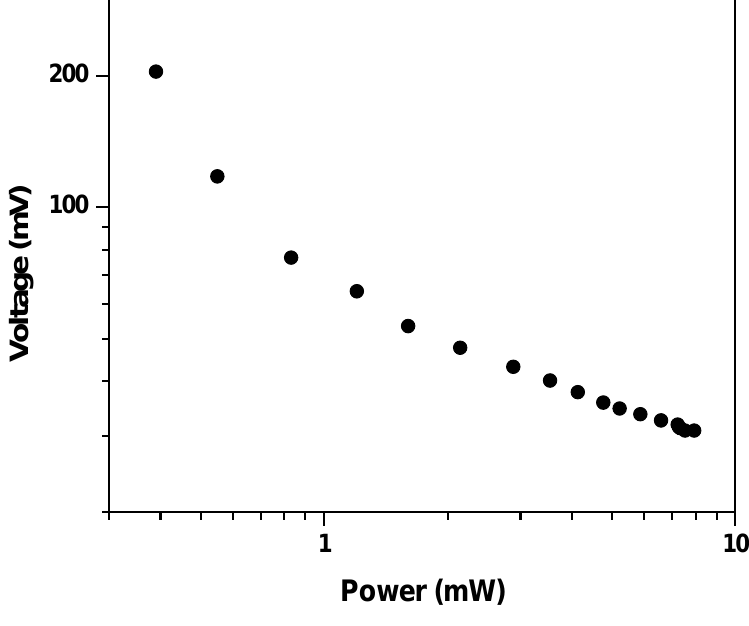
Figure 4. LDR voltage as function of the pulsed light power. The light frequency was 71 Hz. After 1 mW a linear fit was calculated using the software Origin.